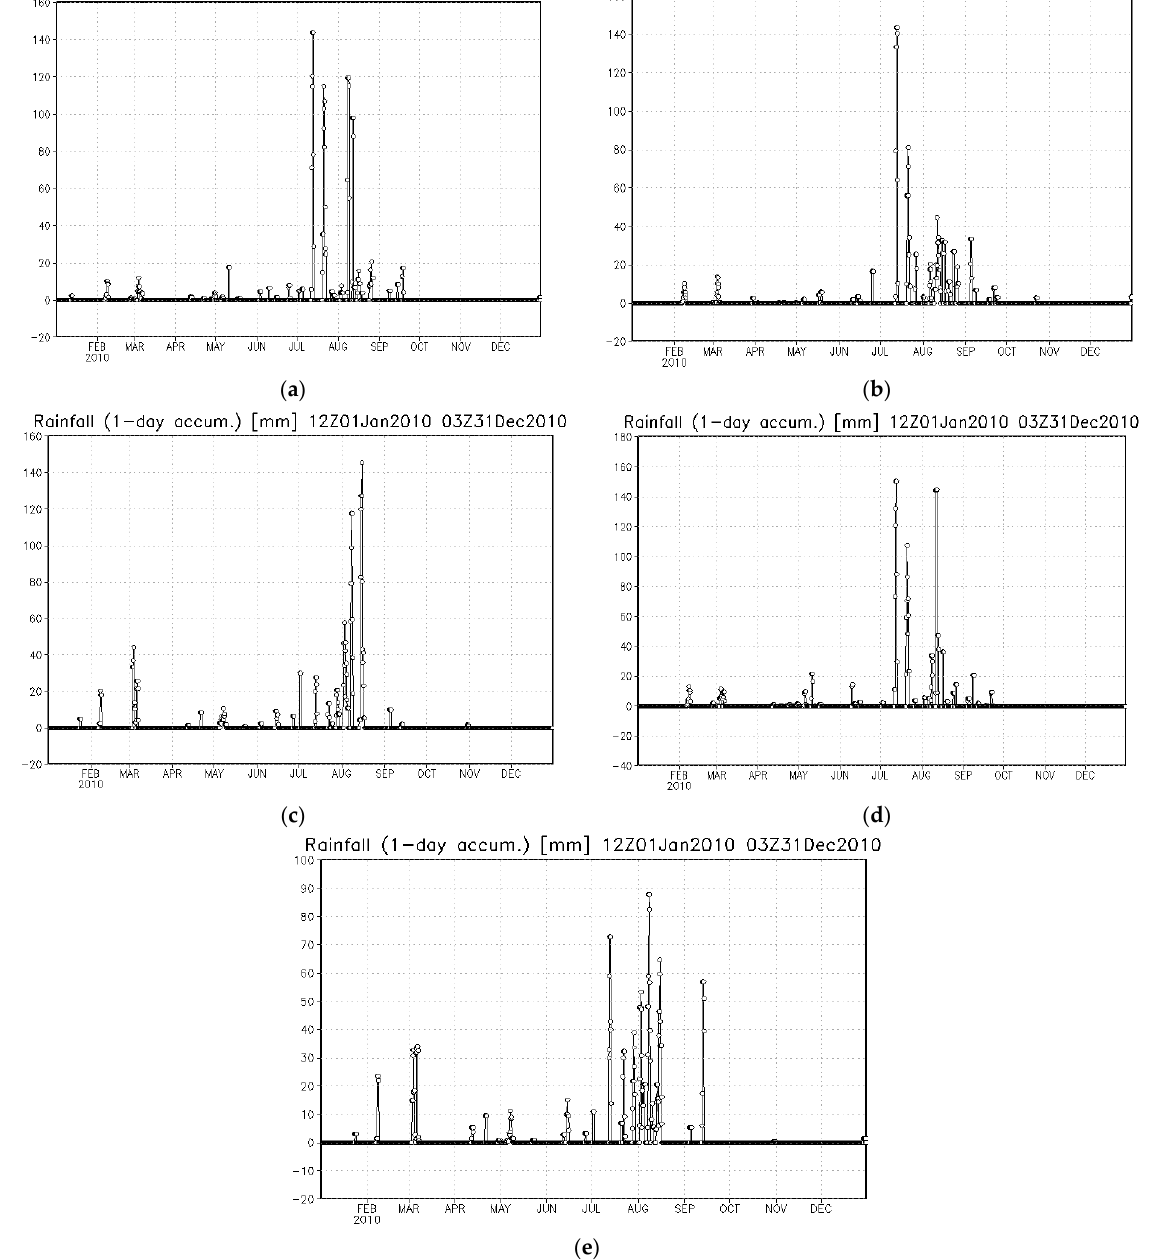
Figure 8. Real-time TRMM rainfall data events with temporal resolution (3 hourly) at relatively high spatial (~1 km) spatial–temporal evolution (real-time daily rainfall input data in mm), over five stations. Here, ( a ) represents St. 1, and ( d ) presents St. 4, showing the central plain, while ( b ) presents St. 2 in the north of the plain, ( c ) represents St. 3, and ( e ) represents St. 5 in the south of the plain,